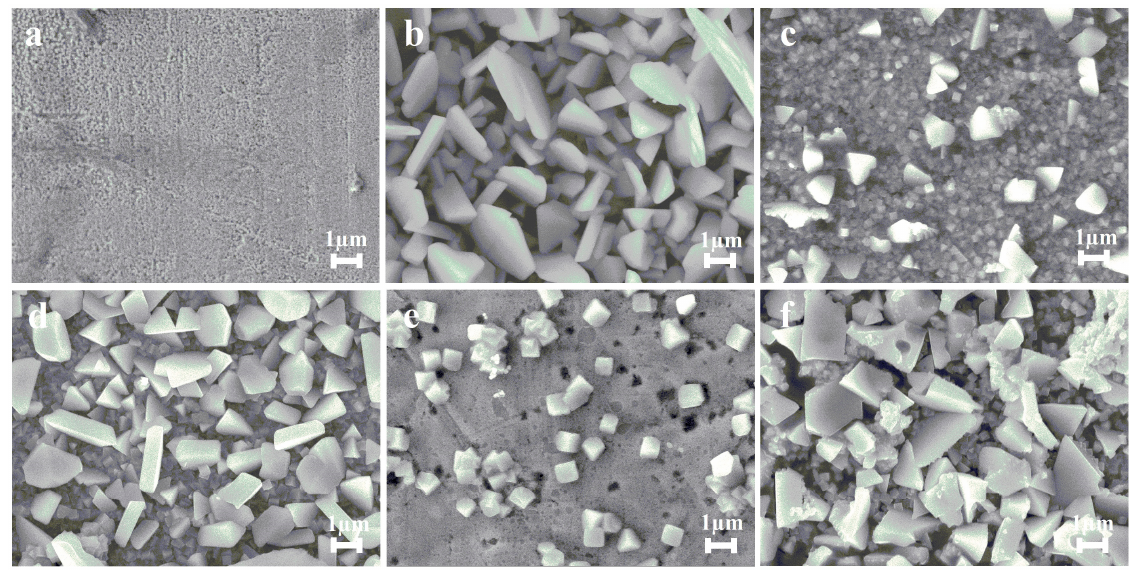
Figure 8. SEM images of nonmodified thin film ( a ), synthesized copper particles manufactured at a KBr concentration of 0 g L − 1 ( b ); 0.15 g L − 1 ( c ); 0.5 g L − 1 ( d ); 1.0 g L − 1 ( e ); 1.6 g L − 1 ( f ) in the working solution.